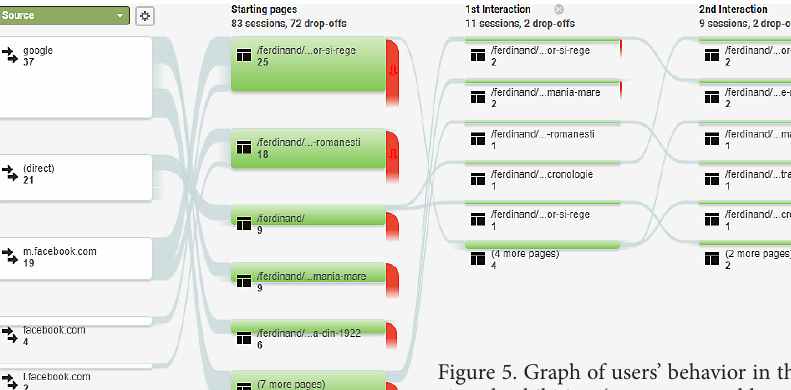
Figure 5. Graph of users’ behavior in the virtual exhibition (source: created by